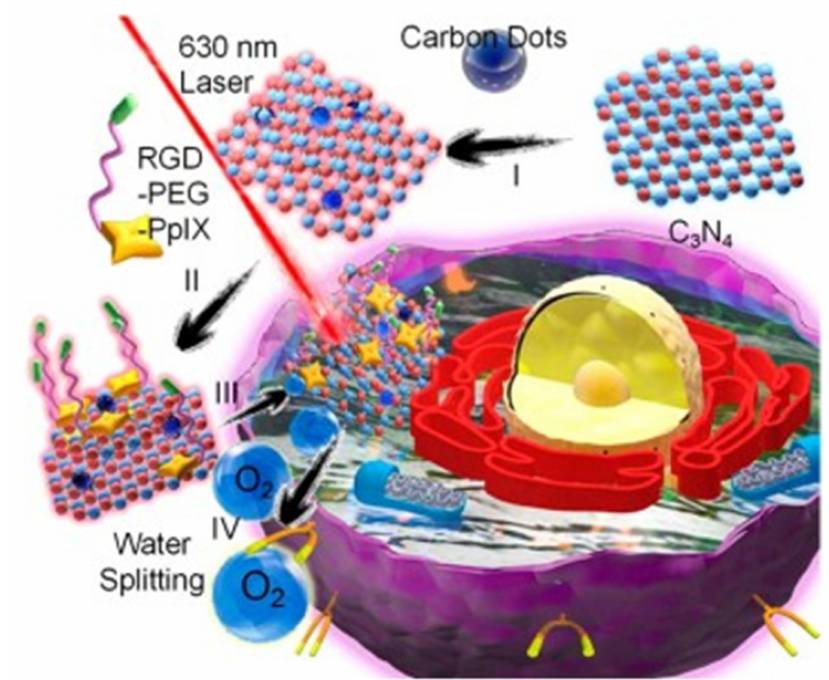
Figure 4. Structure of PCCN and the schematic diagram of 630 nm light-driven water splitting enhanced PDT [5] (I) carbon dot doping to prepare carbon-dot-doped C 3 N 4 ; (II) PpIX-PEG-RGD self- assembly to prepare PCCN; (III) receptor-mediated endocytosis of PCCN; (IV) 630 nm light-driven water splitting to produce O 2 , in which O 2 enhances PDT to produce ROS and kill the cancer